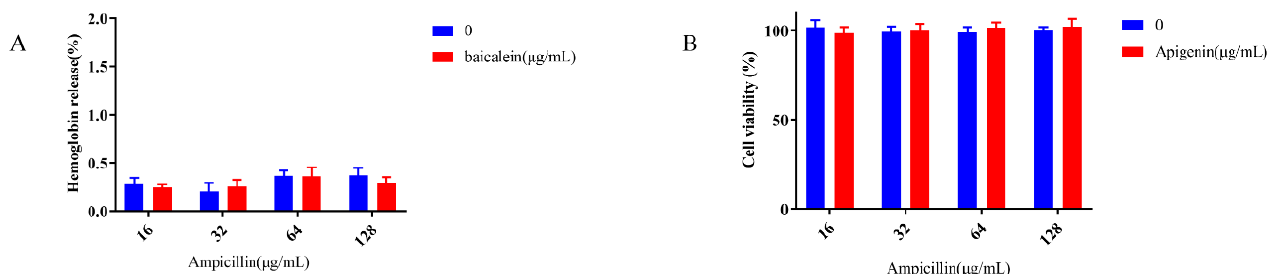
Figure 2. Effect of apigenin on the safety of ampicillin. ( A ) Hemolytic activity of ampicillin to the red blood cells (RBCs) in the absence or presence of apigenin. ( B ) Addition of apigenin exerts a negligible effect on the cytotoxicity of ampicillin in verocells.